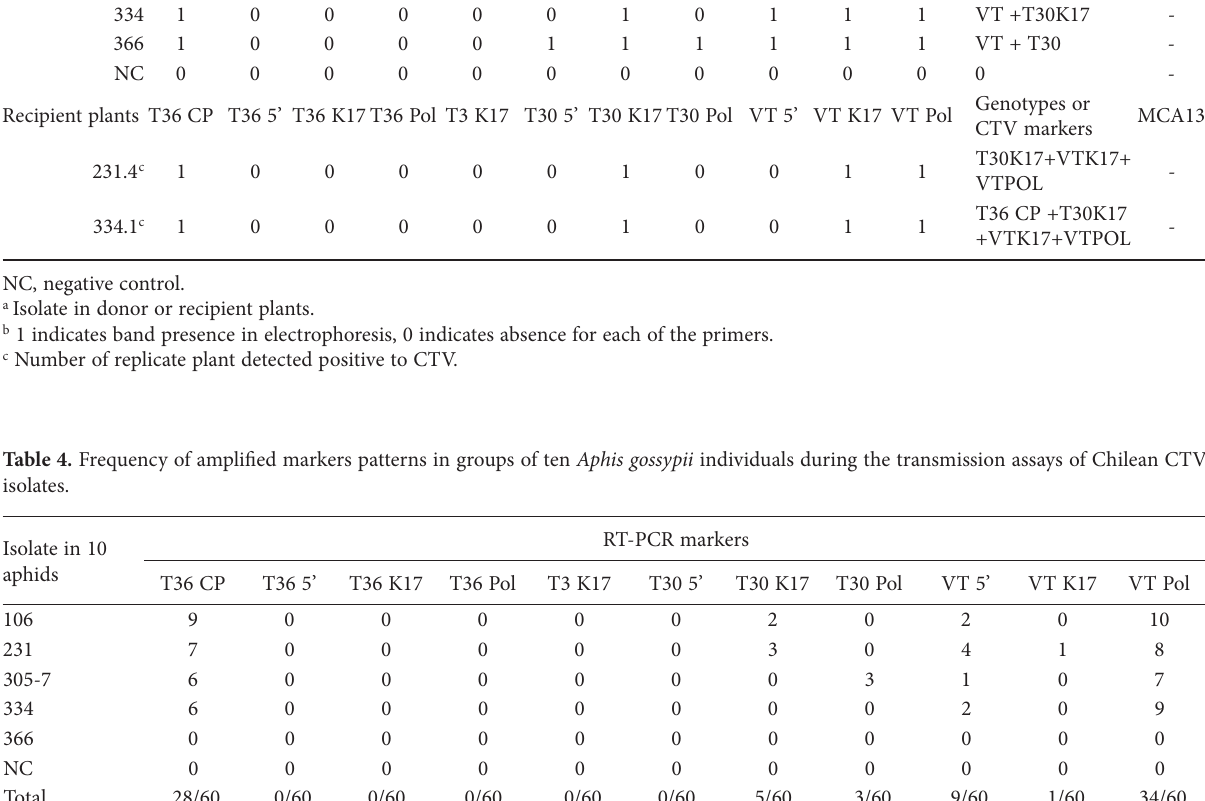
Table 5. Efficiency of CTV acquisition and transmission by Aphis gossypii in lots of ten aphids per isolate, with ten replicates per iso- late and 24 h inoculation access periods and 24 h acquisition access periods.